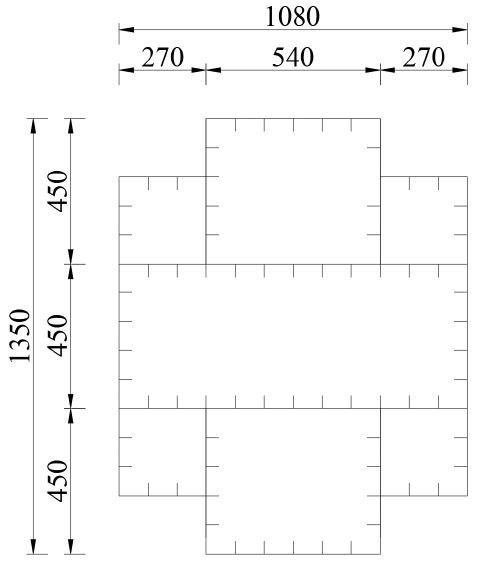
Figure 5. Structure of bridge pylon cross-section.